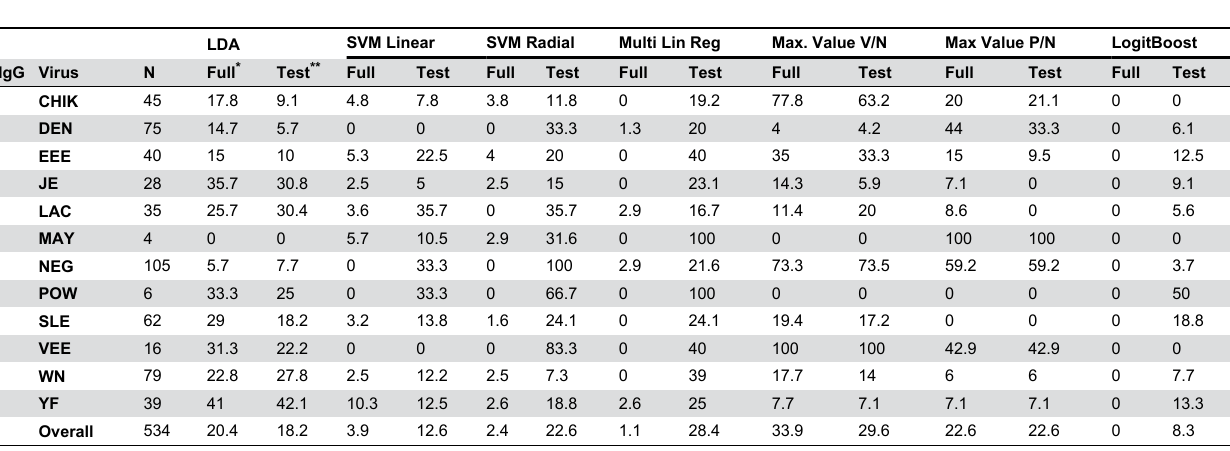
Table 5. IgG multiplex MIA error rates (%) for each virus based on initial serum set.